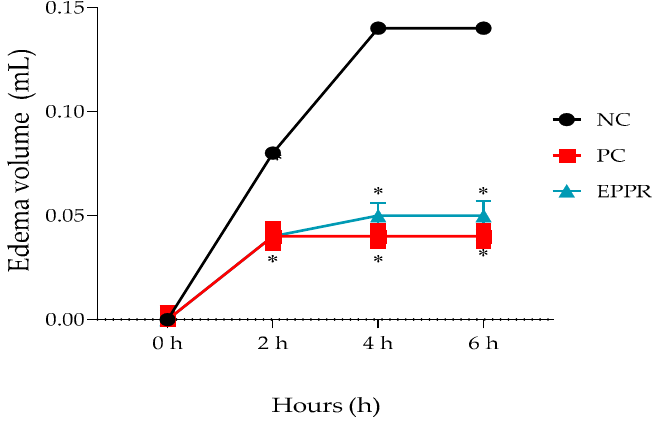
Figure 8. Percentage of edema inhibition in mL (n = 8/group) by the negative control (NC; base gel), positive control (PC; dexamethasone gel 1 mg/g), and EPPR (EPPR gel, 5 mg/g). One-way ANOVA followed by the Tukey–Kramer multiple comparison tests showed * p ˂ 0.005 compared with the NC group. Table 4. Anti-inflammatory activity of the gels in mean percentage, represented by the ability to inhibit carrageenan-induced paw edema at different time points.